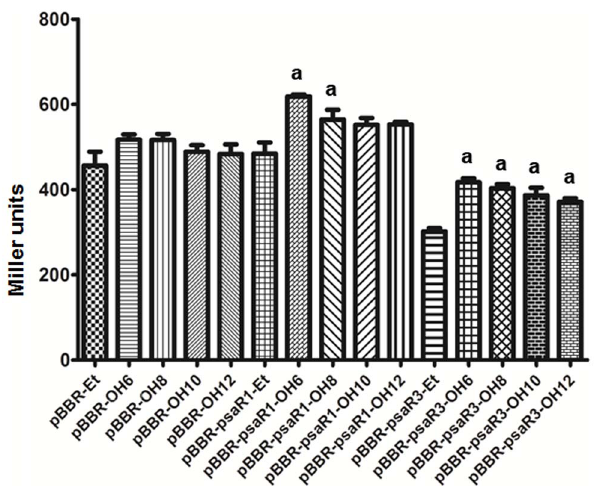
Figure 5. Response of PsaR1 and PsaR3 to AHLs. Histogram reporting gene promoter activity of E. coli harboring pMULTIAHLPROM in the presence of either pBBR, pBBR- psaR1 and pBBR- psaR3 plasmids and different hydroxy AHLs (OH-C6-AHL, OH-C8-AHL, OH-C10-AHL and OH-C12-AHL). All measures were performed in biological triplicates, and the mean Miller units with standard deviations are shown. Promoter activity was statistically significantly ( P , 0.05) increased (a) in the presence of OH-C6-AHL and OH-C8-AHL for PsaR1 compared to respective pBBR empty vector control. Similarly, for PsaR3 statistically significantly ( P , 0.05) increase (a) in lacZ expression was observed in the presence of OH-C6-AHL, OH-C8-AHL, OH-C10-AHL and OH-C12-AHL compared to respective pBBR empty vector controls.